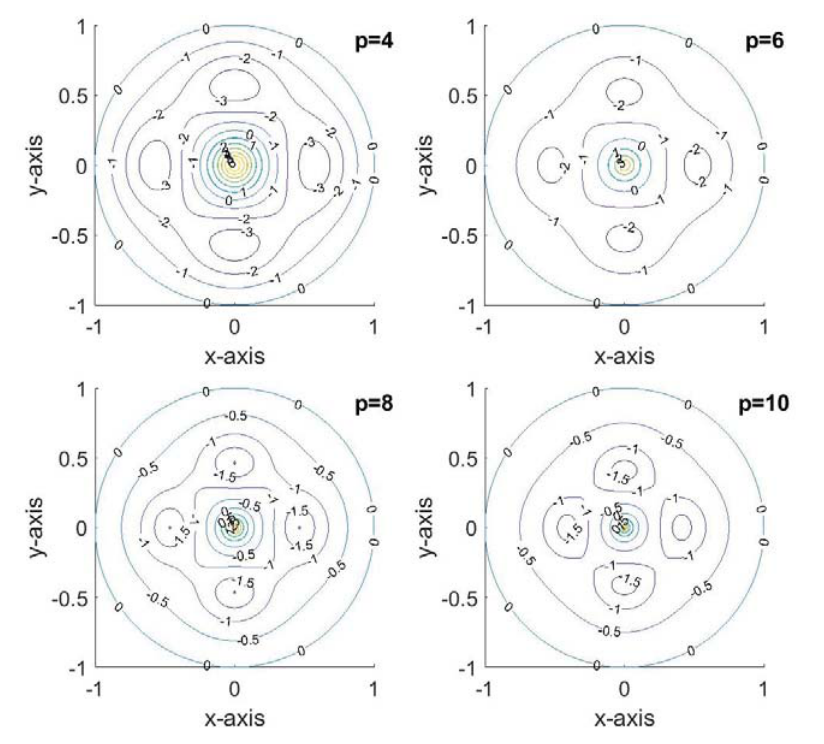
Fig. 15: Level sets of the numerical solutions with two nodal regions and